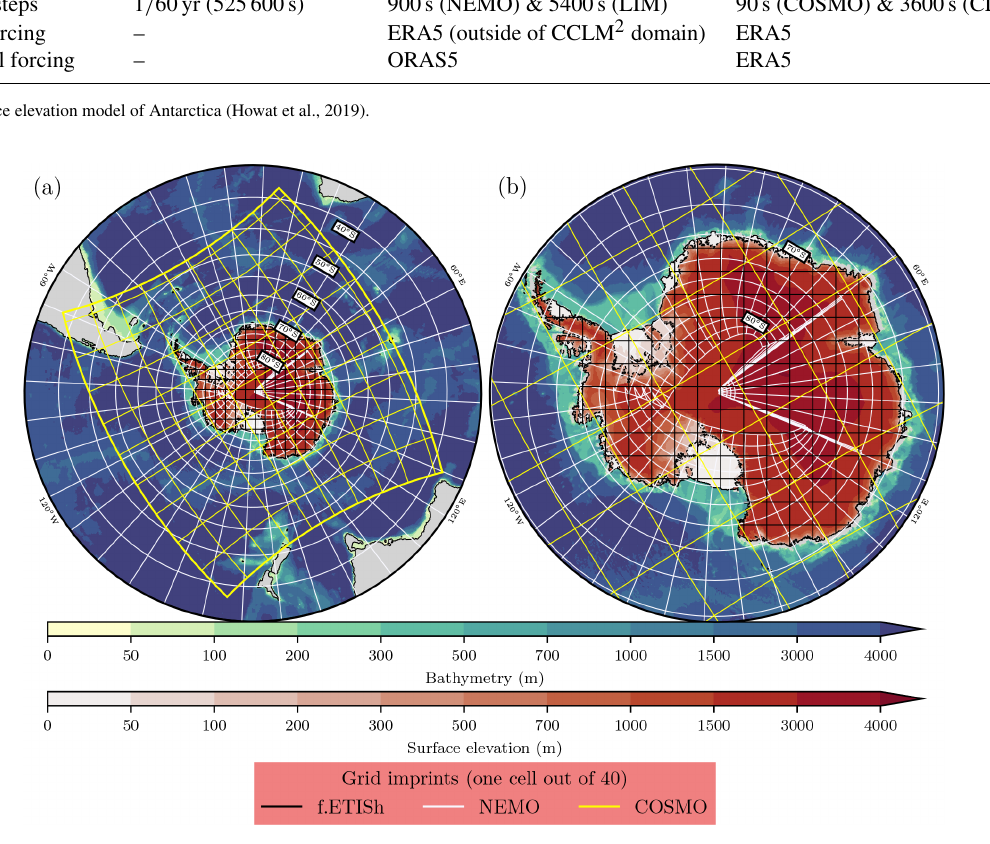
Figure 4. PARASO configuration geometry over (a) the full NEMO domain (cut at 30 ◦ S) and (b) Antarctica. The two color maps indicate the bedrock bathymetry and the ice surface elevation (Morlighem et al., 2020) over Antarctica (note the nonlinear scale). The lines represent the f.ETISh, NEMO and COSMO grids (for the sake of readability, not all cells are